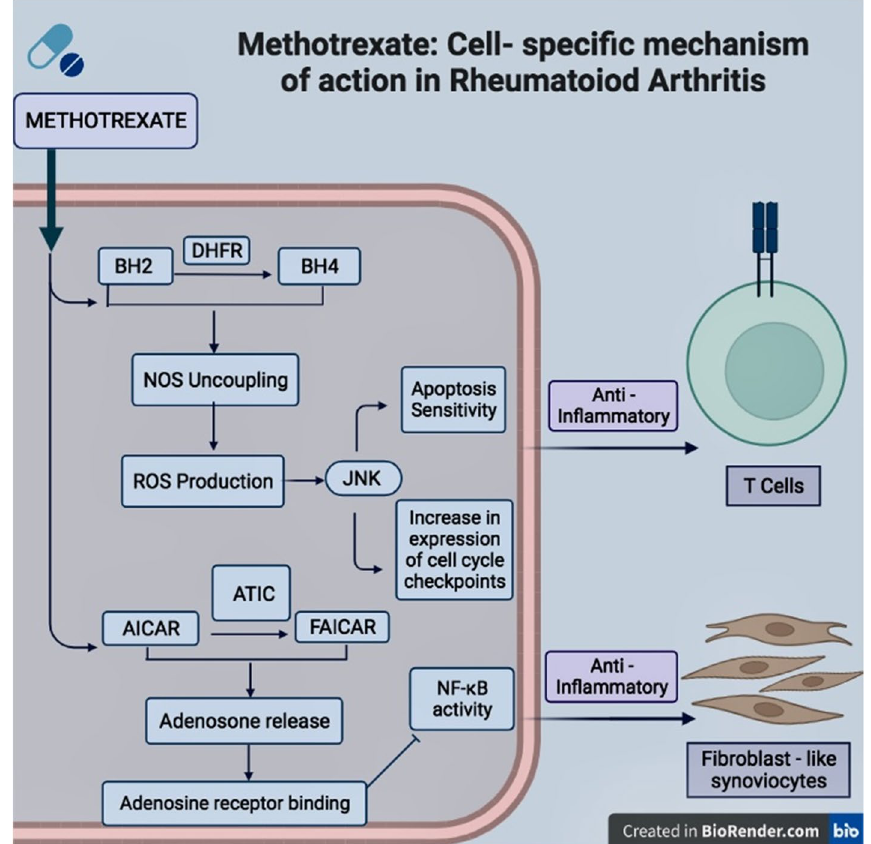
Fig. 1 Methotrexate: Cell—specific mechanism of action in Rheumatoid Arthritis. With respect to T cells, methotrexate causes the inhibition of the dihydrofolate reductase (DHFR)-mediated reduction of dihydrobiopterin (BH2) to tetrahydrobiopterin (BH4). This results in nitric oxide synthase (NOS) uncoupling and increased production of reactive oxygen species (ROS). The ROS activate JUN N-terminal kinase (JNK). In turn, the activated JNK induces genes encoding proteins that regulate sensitivity to apoptosis and cell cycle progression. In the case of fibroblast—like synoviocytes, methotrexate causes inhibition of of 5-aminoimidazole-4-carboxamide ribonucleotide (AICAR) transformylase (ATIC). This causes increased release of adenosine and activation of adenosine receptors, resulting in the inhibition of NF-κB with subsequent anti-inflammatory effects